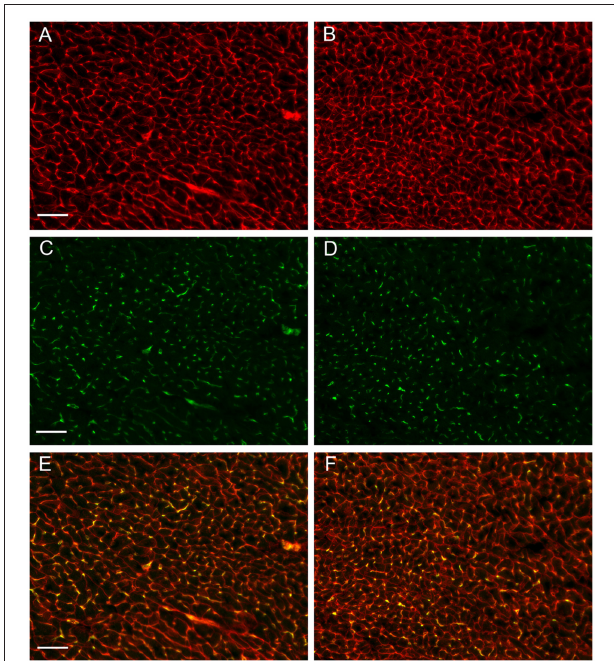
FIGURE 3 | Sections prepared from cardiac tissue taken from the animals used for PV-Loop measurements. (A,B) myofiber staining, (C,D) capillary staining, (E,F) overlay of A,C, and B,D , respectively. A,C,E are from WT hearts, B,D,F are from AQP1- KO hearts. Bar length 50 µ